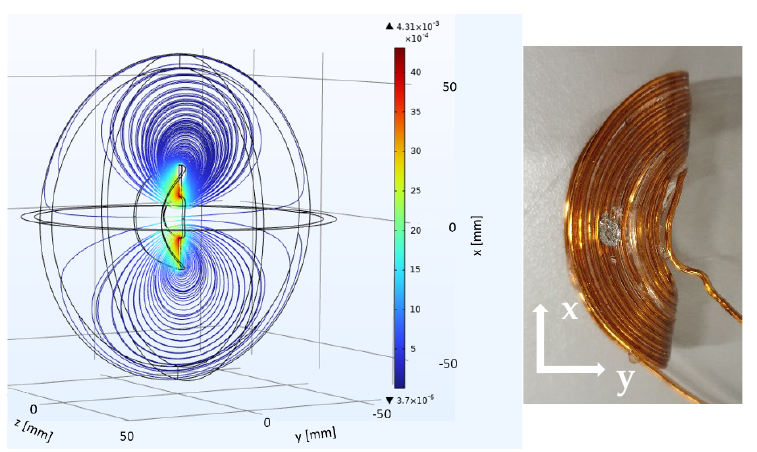
Figure 2 . Left : Simulation of the absolute value of the RF-field | B 1 ( r )| of the homogenized version of the spirally wound, bent surface coil. The coils’ geometry is indicated by the inner black lines, while | B 1 ( r )| is color encoded along the scale from blue (low values) to red (high values) and shown along the three spatial coordinates. Right : A picture of the coil with the coordinate system. The sample is aligned along x and positioned cantric to the coil.